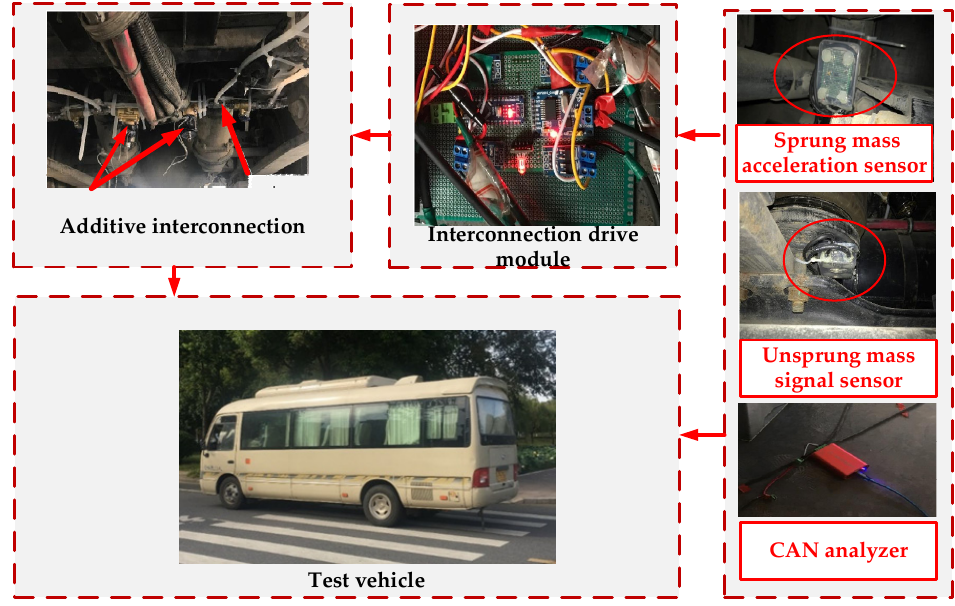
Figure 9. Schematic diagram of the test system. Table 3. Specification of acceleration sensor.